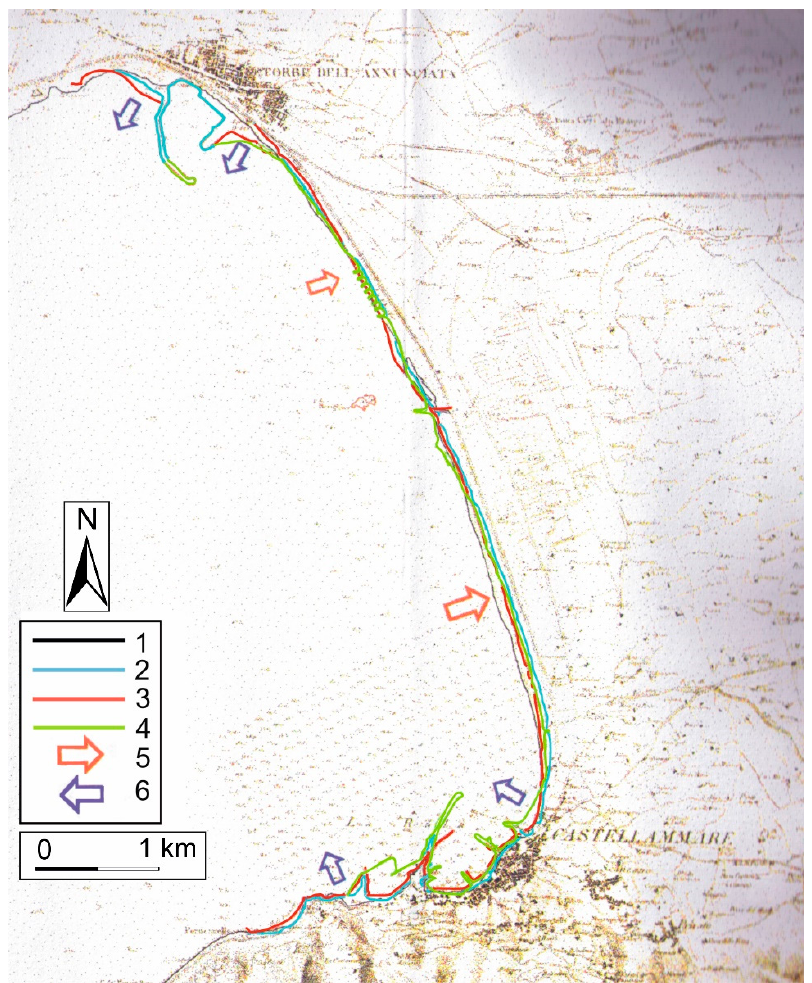
Figure 6. Shoreline evolution from 1865 to 2018. Legend: 1—1865 shoreline before the Torre Annunziata harbor was built; 2—1872/76 shoreline after the Torre Annunziata harbor was built; 3—1941 shoreline; 4—2018 shoreline; 5—erosional beach; 6—progradational beach.